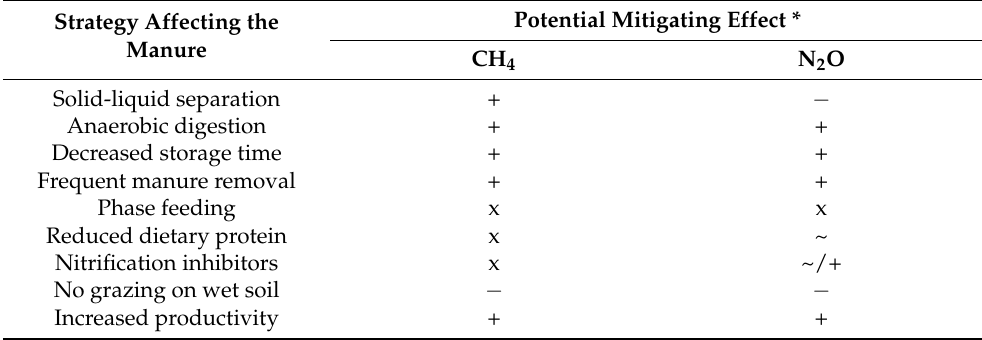
Table 11. Emissions reduction on potential of various strategies of the manure affecting. Potential Mitigating Effect * Strategy Affecting the Manure CH 4 N 2 O Solid-liquid separation + − Anaerobic digestion + + Decreased storage time + + Frequent manure removal + + Phase feeding x x Reduced dietary protein x ~ Nitrification inhibitors